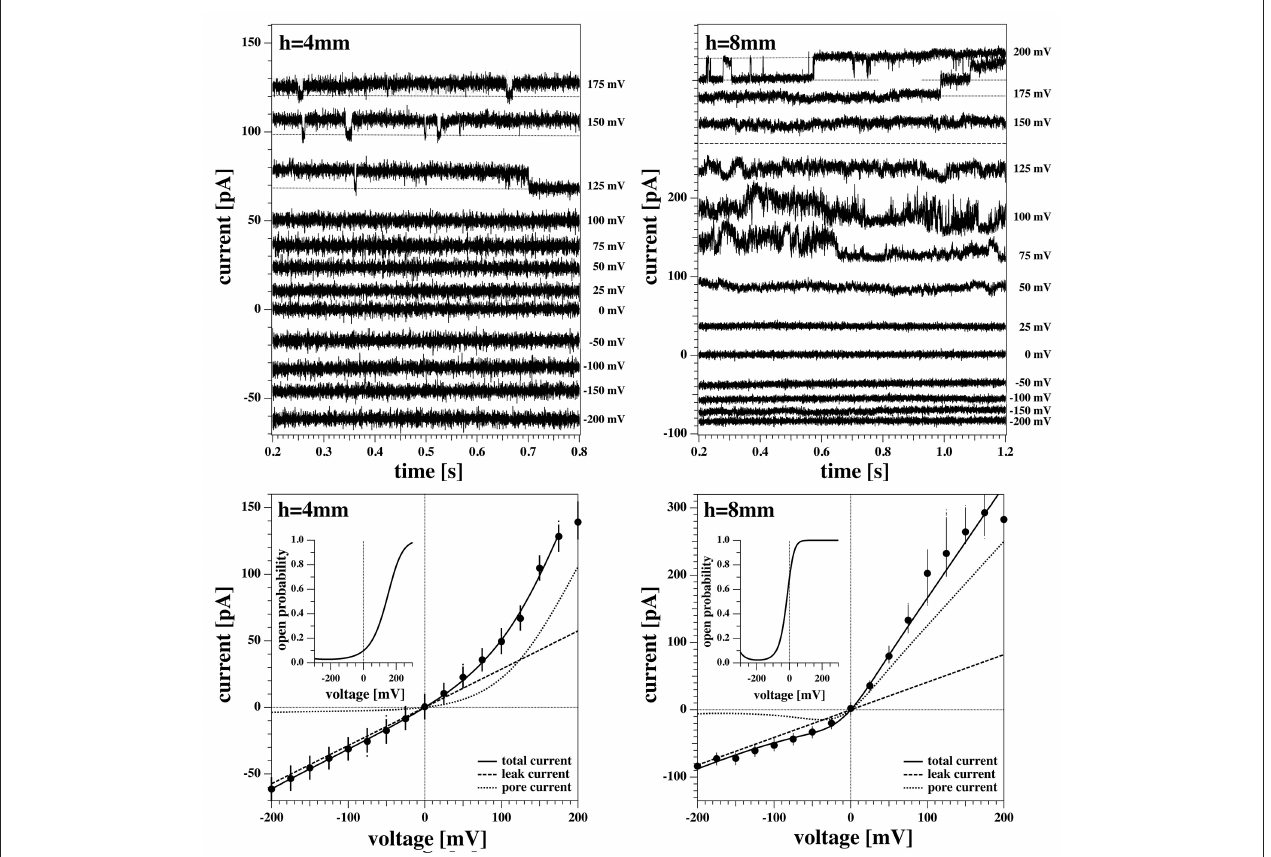
FIGURE 8 | Current response of membrane 2 at 4 mm (Left) and 8 mm (Right) below the water surface. The current response to negative voltages doesn’t show current fluctuations. (Left) The membrane current at high positive voltages shows quantized steps to a lower current value before jumping down to it and staying there for the lower voltages. The current response at 200 mV shows a constant drift in the baseline and is not shown here. (Right) The current responses to 200, 175, and 150 mV have been shifted to the top panel for clarity as they overlap. The membrane shows current fluctuations for increasing voltages. They end up in well-defined quantized steps at high voltages when pores are open most of the